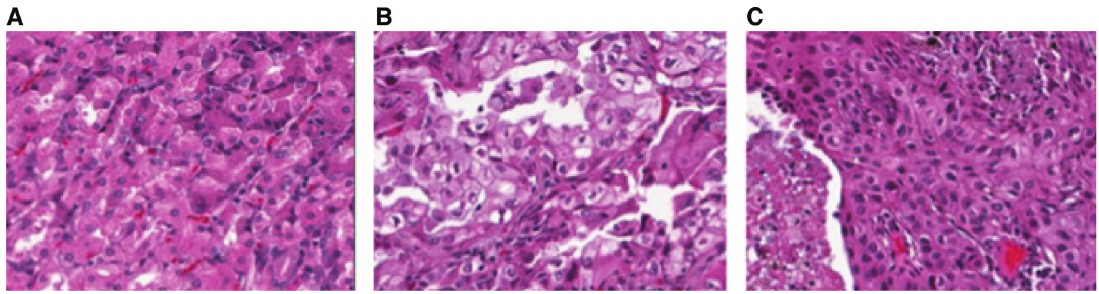
Figure 3: ROI applied images. (A) ROI-applied normal image, (B) ROI-applied adenocarcinoma image, (C) ROI-applied squamous